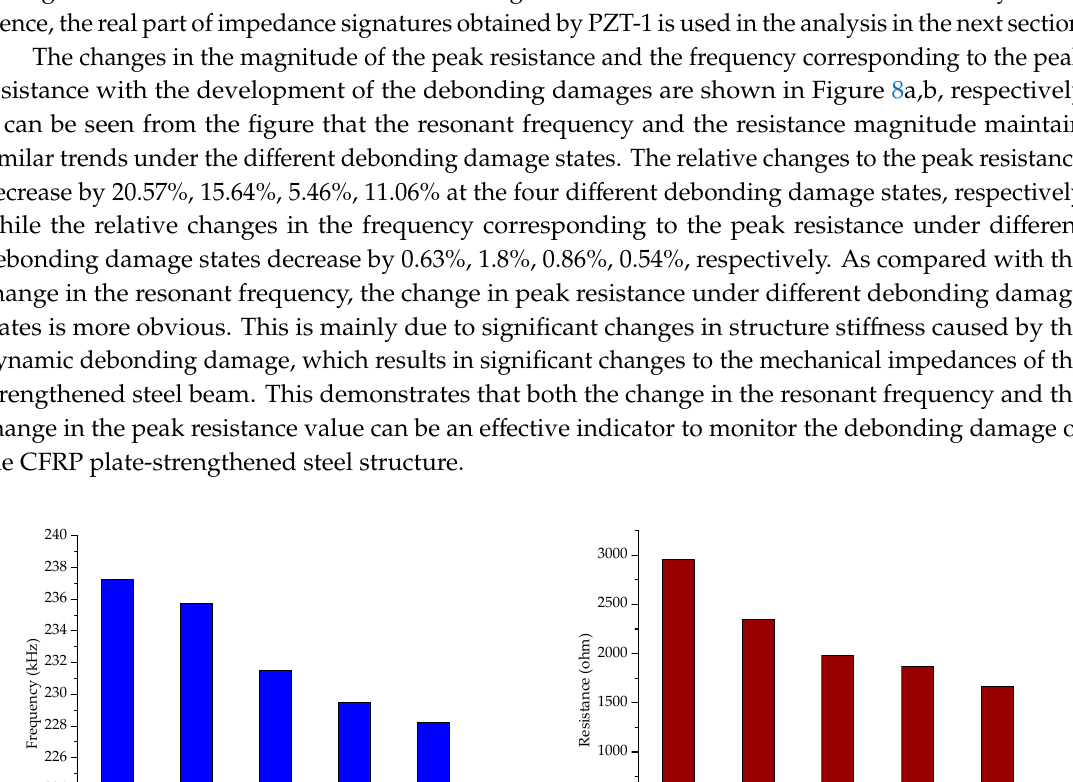
Damage state Figure 9. The value of root-mean-square-deviation (RMSD) for different debonding damage at the frequency range of 200–260 kHz at PZT-1.